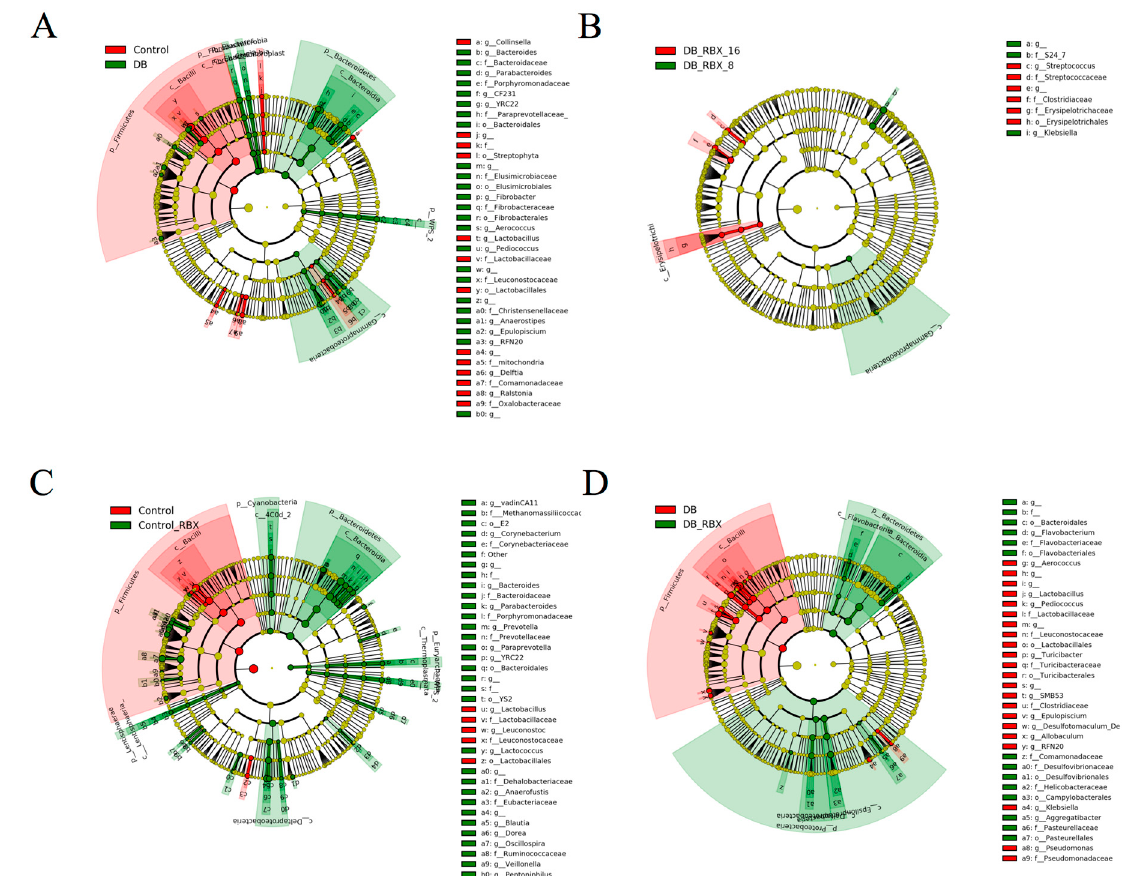
Figure 2. LEfSe cladograms indicating significantly differential taxa. ( A ) Control vs. RBX-treated rats. ( B ) Diabetic vs. RBX-treated diabetic rats. ( C ) Diabetic rats vs. nondiabetic control